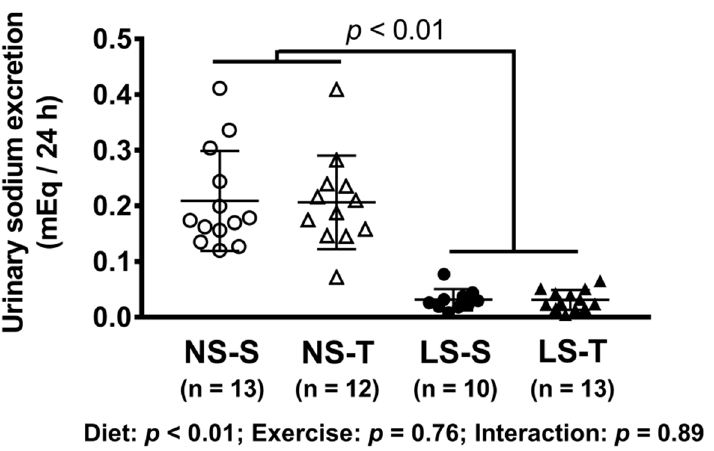
Figure 1. Urinary sodium excretion (mEq/24 h). Data presented as mean ± SD. Results compared by 2-way ANOVA (GLM; fixed factor: diet and exercise). p value shows difference between NS and LS groups. p exercise = 0.94; p diet*exercise = 0.94. NS = normal-sodium diet; LS = low-sodium diet; S = sedentary; T = trained.